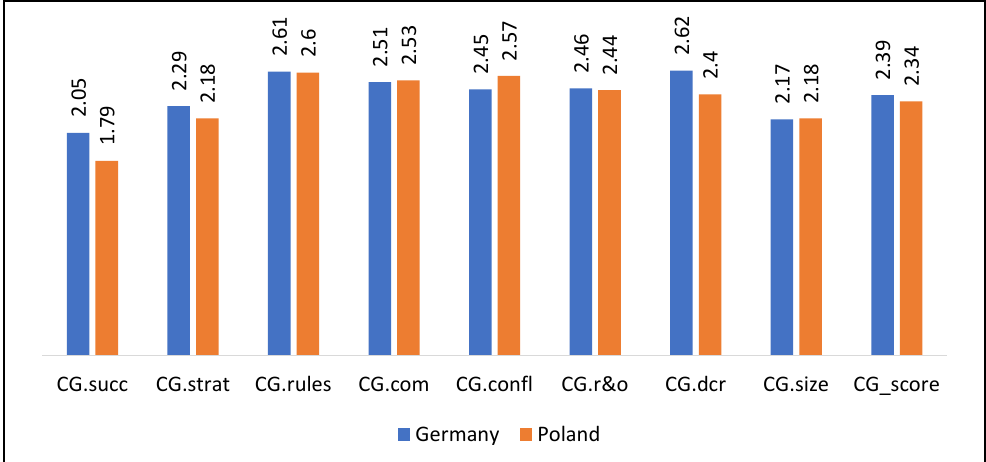
Figure 4. Strength of CG mechanisms construct: Survey results for SMEs in Germany and Poland. Table 8. Strength of corporate governance mechanisms construct: SMEs in Germany vs SMEs in Poland.